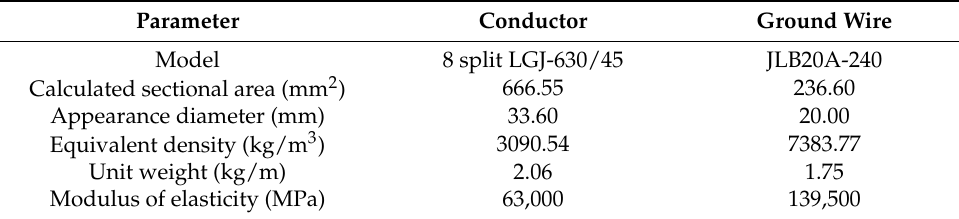
Figure 1. Transmission tower-line system: ( a ) tower-line system; ( b ) plane view of the tower; ( c ) 3-D isometric view of transmission tower model. Table 1. Main physical parameters of the conductors and ground